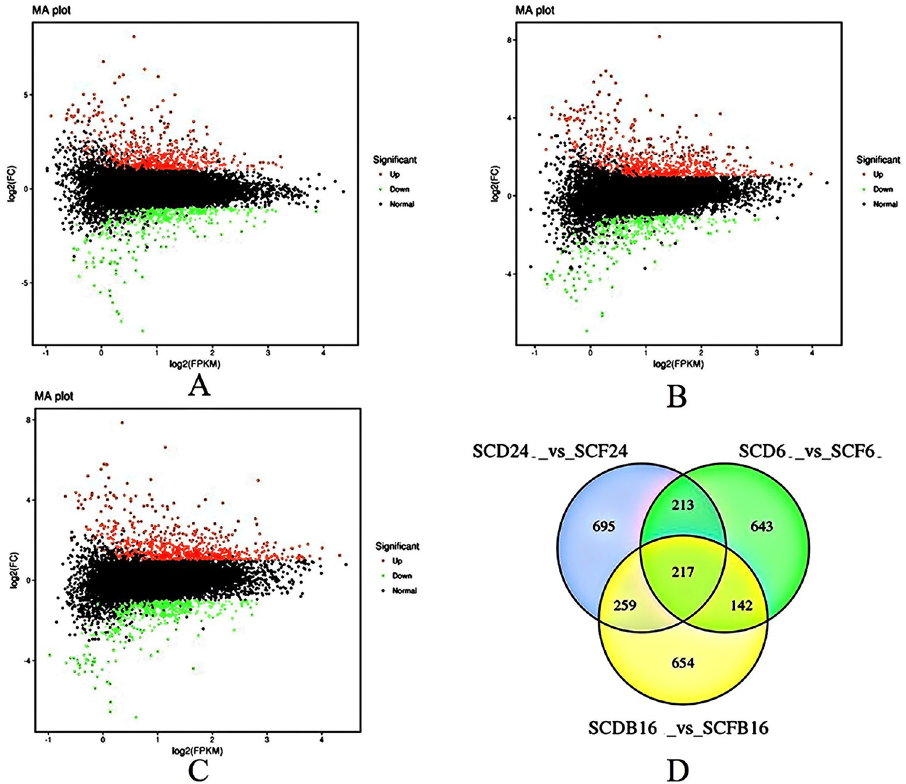
Fig 1. Statistical analysis of DEGs under CO 2 enrichment in S6, S16 and S24. (A) MA diagram of differential genes in S6. (B) MA diagram of differential genes in S16. (C) MA diagram of differential genes in S24. (D) Venn diagram of differential genes between carbon-rich group and the control group in the S6, S16 and S24.